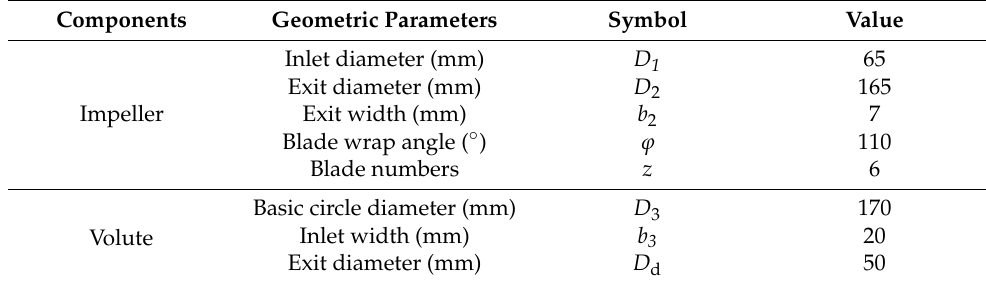
Table 1. Main structural parameters of marine